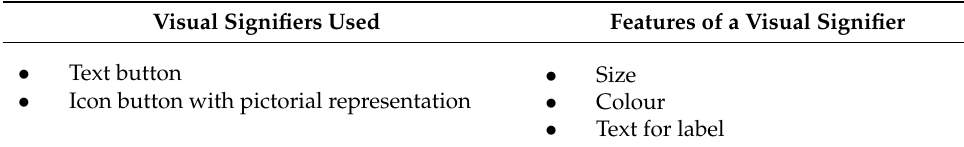
Table 2. Proposed museum signifiers and features for a large